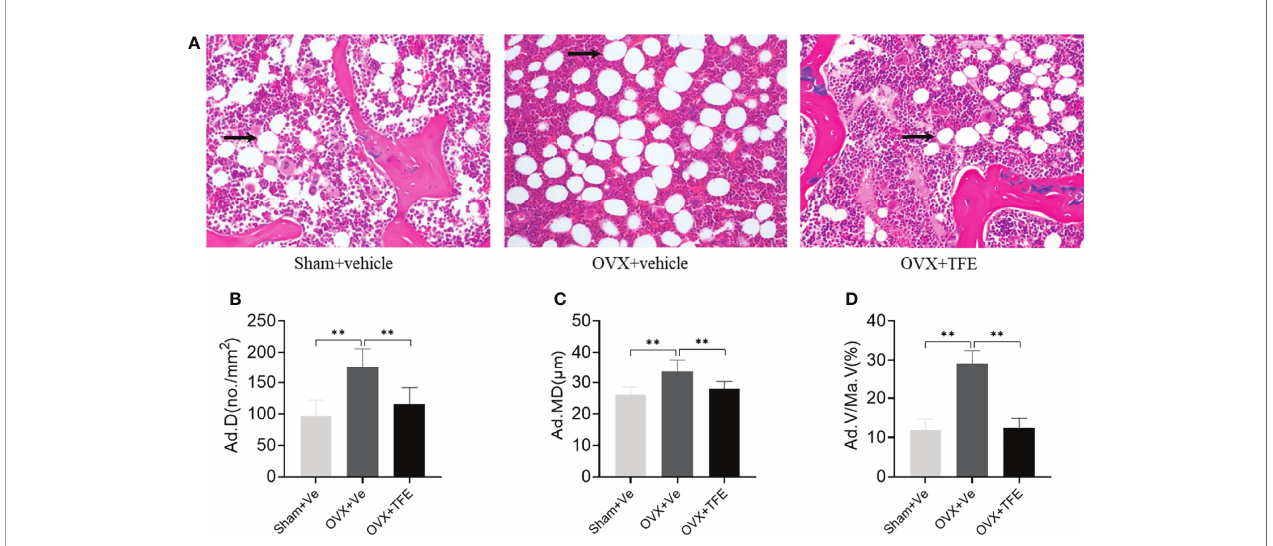
FIGURE 6 | Changes in the marrow adipose (A) and adipocyte quantitative parameters (B – D) . Sections of decalci fi ed bone were stained with H&E (×200). OVX markedly increased in fi ltration of marrow fat (arrow). This increase in marrow adiposity was restored by TFE treatment. Ad.D, adipocyte density; Ad.MD, adipocyte mean